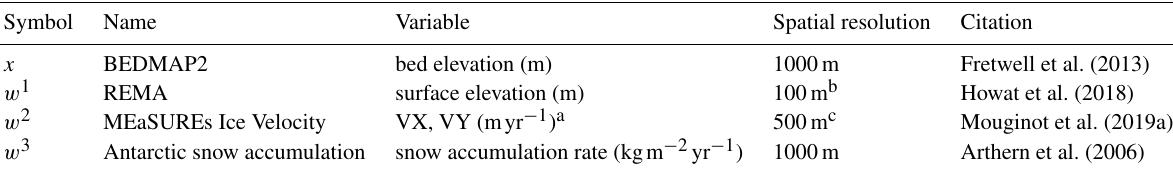
Table 2. Remote sensing dataset inputs into the DeepBedMap neural network model.